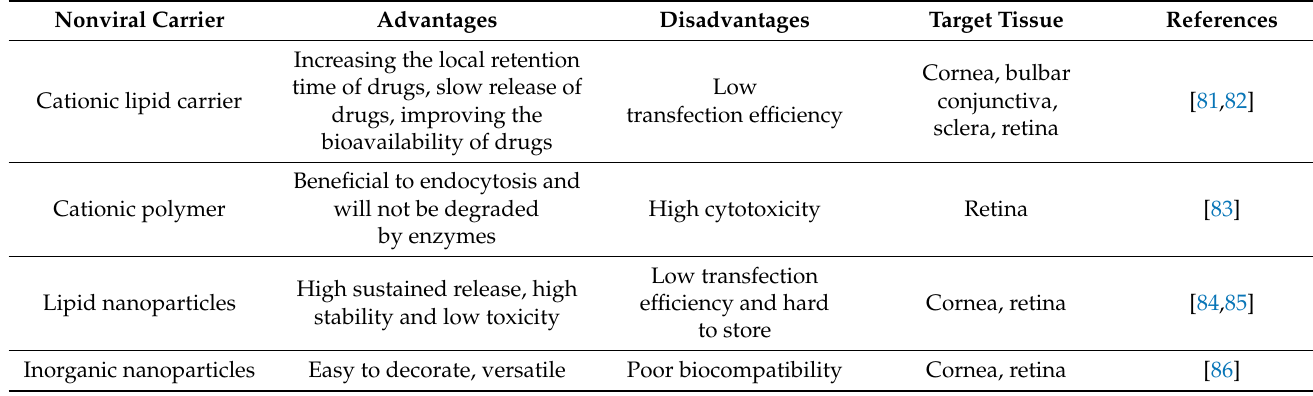
Table 4. Common nonviral carriers of NADs in